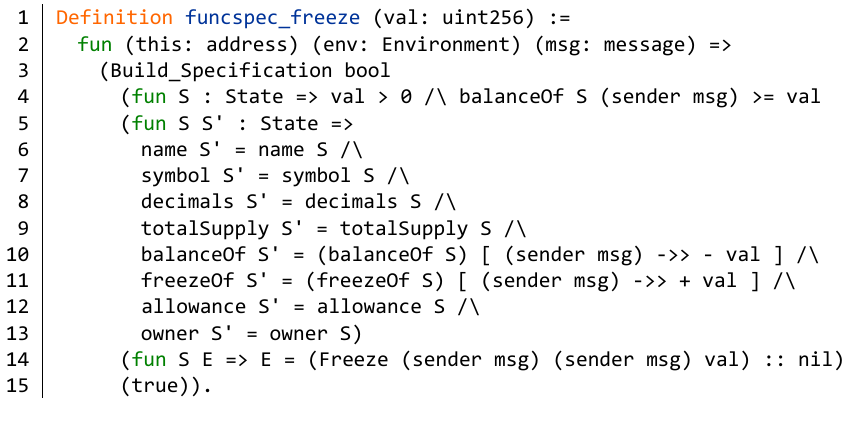
Figure 17. Definition of the specification of the freeze